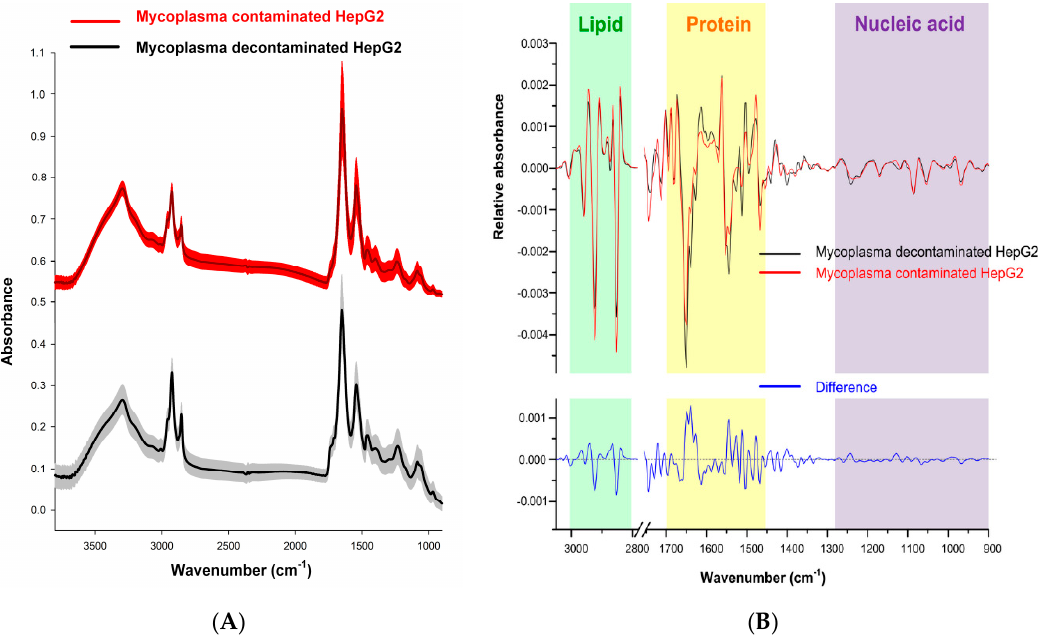
Figure 2. ( A) Average Fourier transform infrared (FTIR) primary and (B) second derivative spectra Figure 2. ( A ) Average Fourier transform infrared (FTIR) primary and ( B ) second derivative spectra of mycoplasma decontaminated ( 67 spectra from triplicate samples ) and contaminated ( 58 spectra of mycoplasma decontaminated (67 spectra from triplicate samples) and contaminated (58 spectra from triplicate samples ) HepG2 cells . Standard deviation was indicated in the primary spectrum and from triplicate samples) HepG2 cells. Standard deviation was indicated in the primary spectrum and displayed as the parallel band with relevant color. displayed as the parallel band with relevant